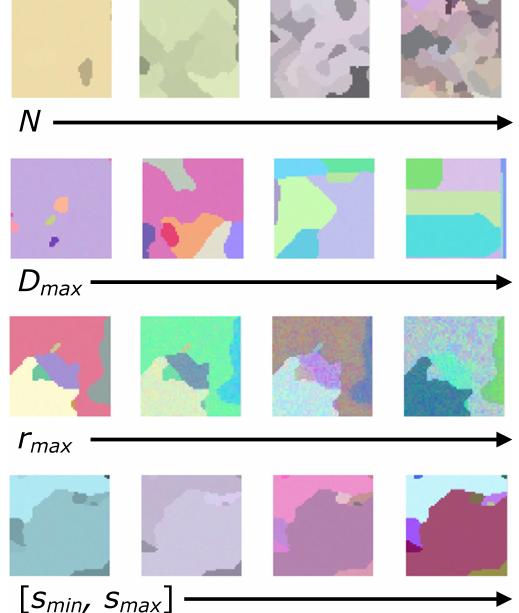
Figure 7. Synthetic RGB images created with the proposed tool. The influence of N , D max , r max